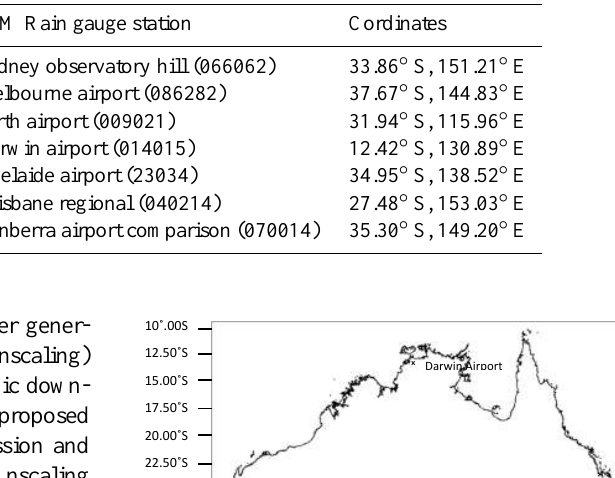
Table 1. Details of study location.